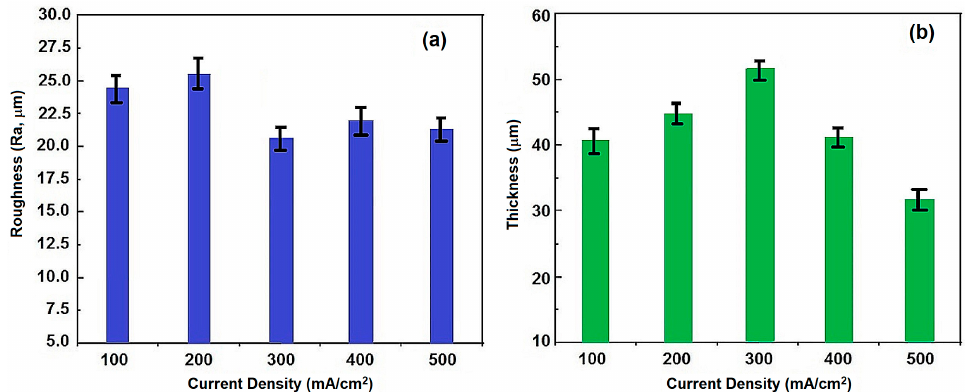
Figure 5. ( a ) Deposit roughness and ( b ) thickness of the coatings at various current densities.